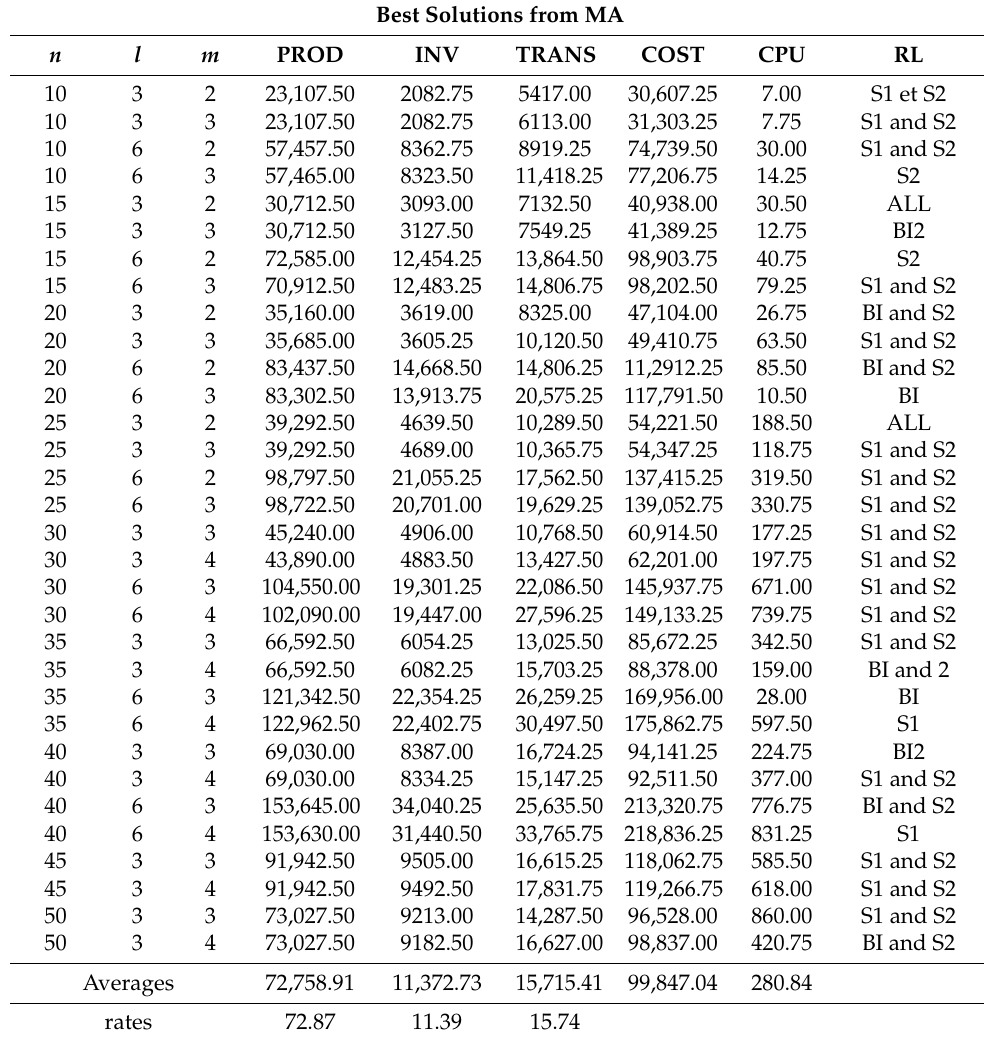
Table 17. Details of the best solutions found in all tests.